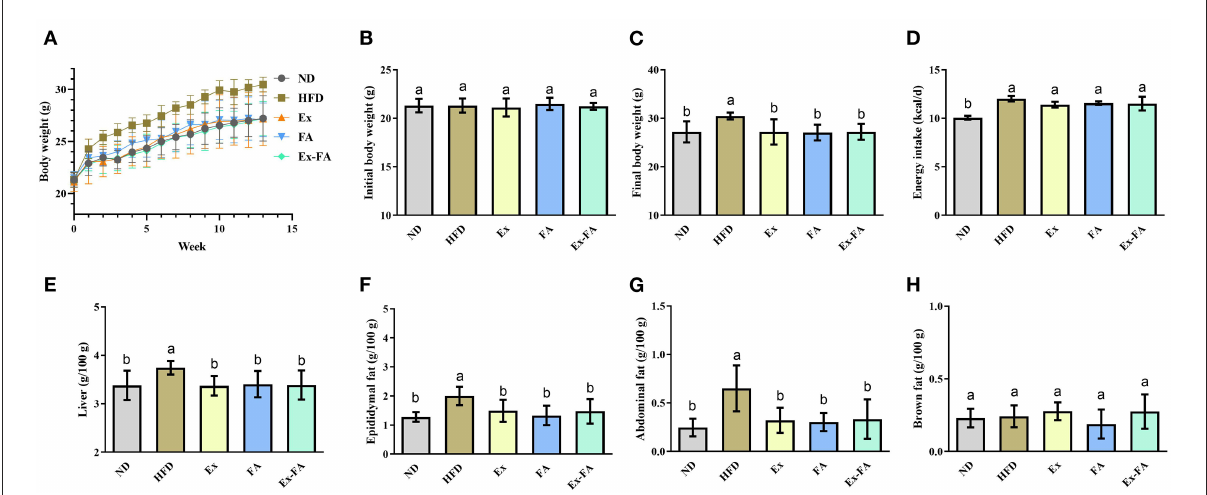
FIGURE1 Effects of Ex, FA, and Ex-FA on body weight, energy intake, and organ indexes in HFD-fed mice. (A) Body weight change; (B) Initial body weight; (C) Final body weight; (D) Energy intake; (E) Liver index; (F) Epididymal fat index; (G) Abdominal fat index; (H) Brown fat index. ND, normal diet group (control); HFD, high-fat diet group (model); Ex, high-fat diet with exercise; FA, high-fat diet with ferulic acid; Ex-FA, high-fat diet with exercise and ferulic acid. Data are expressed as mean ± SD ( n = 6 for energy intake and n = 10 for the others). Means with different letters are significantly different ( P < 0.05).